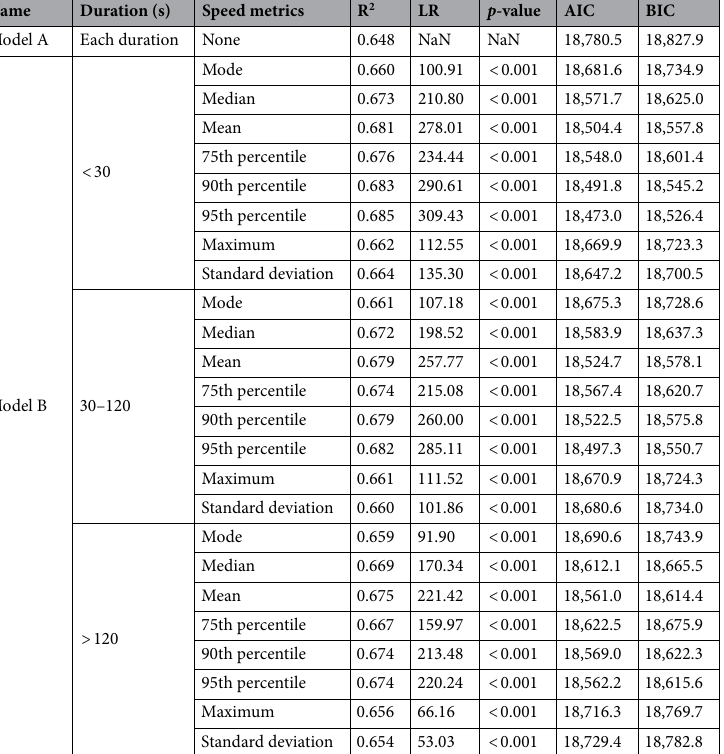
represent only a small percent of daily gait, so the limited number of samples available may decrease the statisti- cal power. The medium bouts appear optimal for the estimation of robust speed metrics because their number is sufficiently high (about 30%), and the duration long enough to correspond to a stable gait pattern.